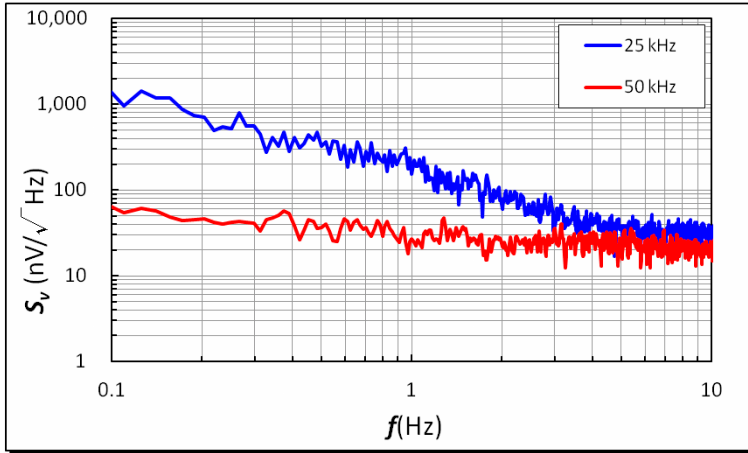
Figure 9. Voltage noise spectral density of the second harmonics under different excitation